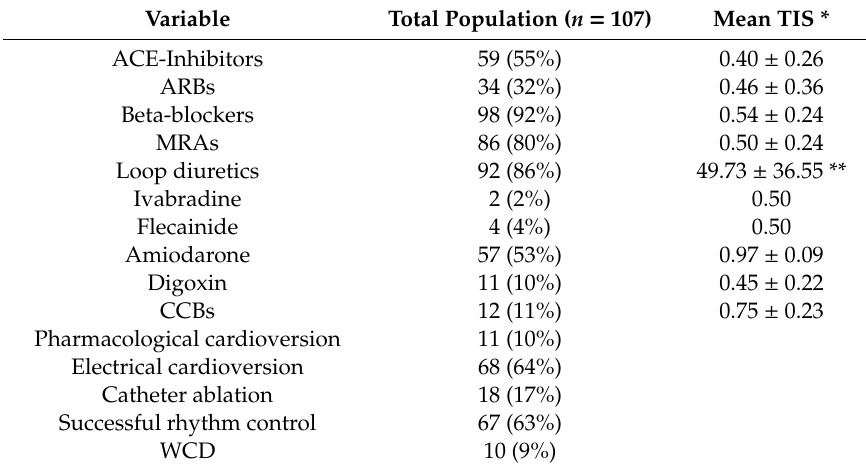
Table 2. Treatment strategies at